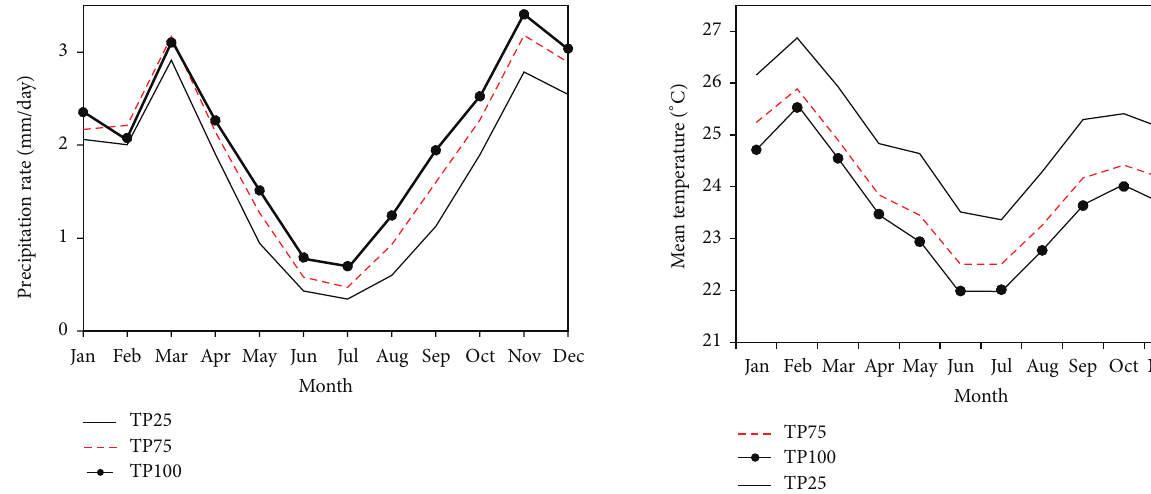
Figure 3: The mean annual cycle of the 2 m temperature (in ∘ C) for the period 2000–2008, averaged over longitudes 28 ∘ E–42 ∘ E and latitudes 12 ∘ S–5 ∘ N. TP100 is due to the simulation with actual topography (control experiment), TP75 is due to the simulation with topography over KTU reduced to 75%, and TP25 represents simulation when the topography is reduced to